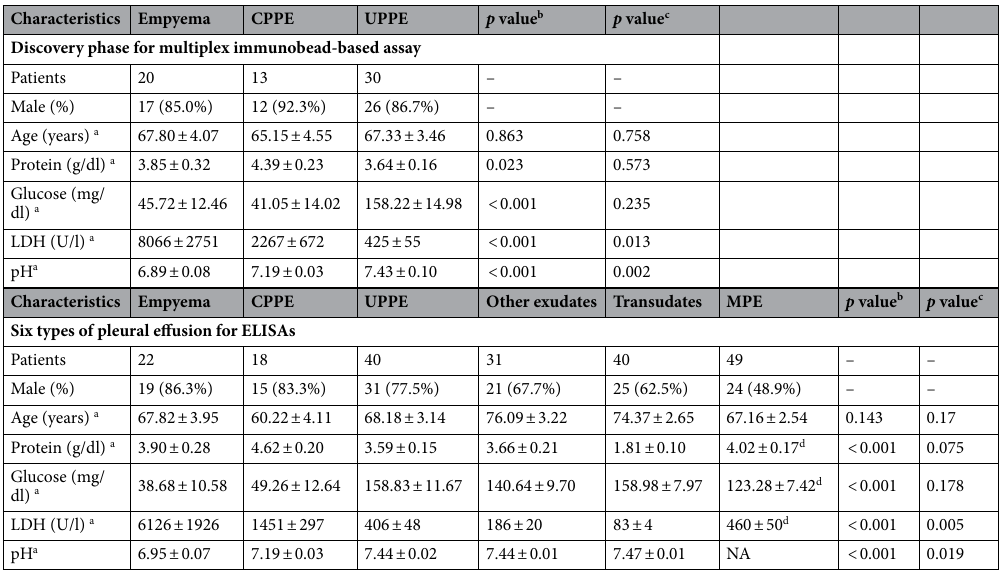
Table 1. Clinical characteristics of the patients in this study. a Data are presented as the mean ± SEM. NA not available, UPPE uncomplicated parapneumonic effusion, CPPE nonpurulent complicated parapneumonic effusion, MPE malignant pleural effusion. The p value on two-tailed Student’s t test indicates the difference between b UPPE and CPPE or the c empyema and CPPE. d Protein, glucose, and LDH data are missing for two patients with